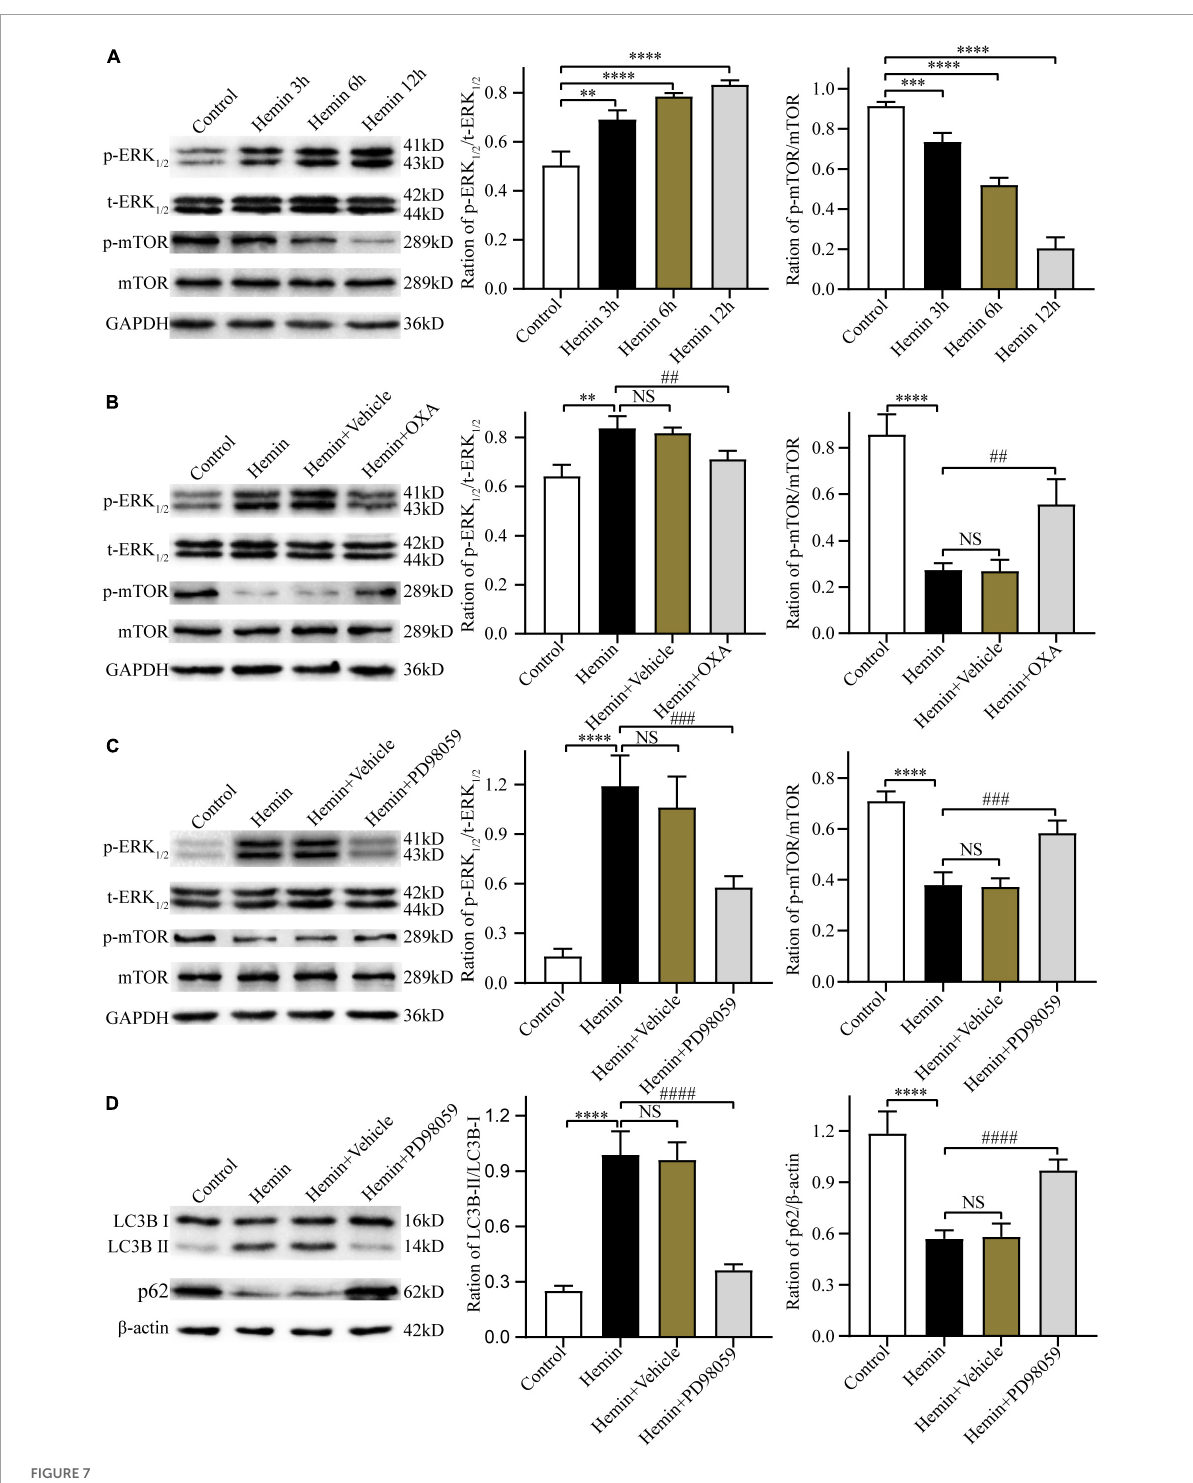
FIGURE7 The neuroprotective effects of OXA are mediated via the ERK/mTOR signaling pathway. (A) Representative western blots of p-mTOR and p-ERK 1 / 2 and results of quantitative analysis in PC12 cells treated with Hemin for 3, 6, and 12 h. (B) Western blot images of p-mTOR and p-ERK 1 / 2 and results of quantitative analysis in each group. (C) Representative western blots of p-mTOR and p-ERK 1 / 2 and results of quantitative analysis in PC12 cells treated with Hemin and PD98059. (D) Western blot images of LC3B and p62 and results of quantitative analysis in each group. ∗∗ p < 0.01, ∗∗∗ p < 0.001 and ∗∗∗∗ p < 0.0001 vs. the control group; NS, non-significant different compared to the hemin group. ## p < 0.01, ### p < 0.001 and #### p < 0.0001 vs. the hemin